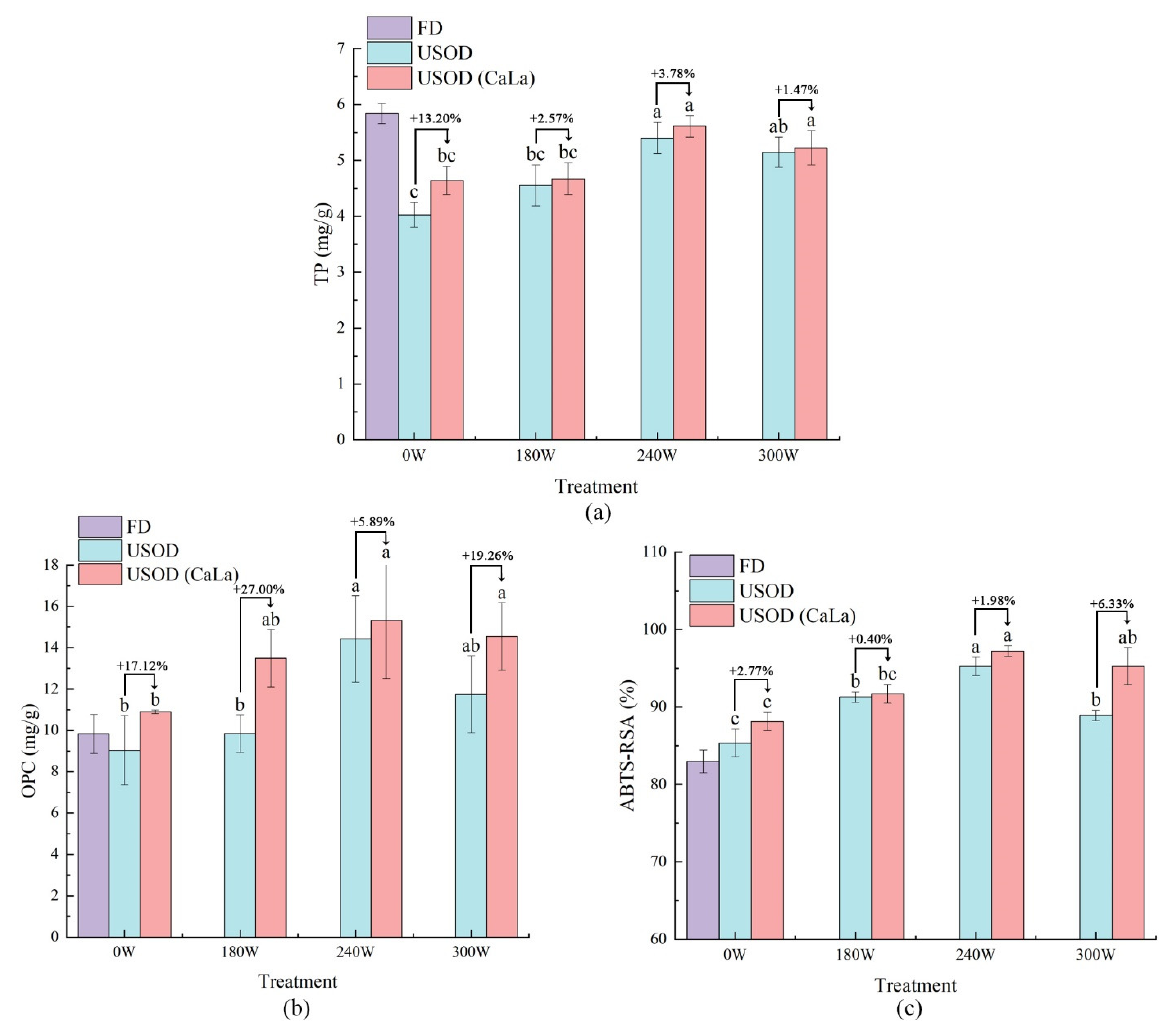
Figure 5. TP ( a ), OPC ( b ) and ABTS-RSA ( c ) of freeze-dried yellow peach slices with different treatments. The means between different ultrasonic power levels on the same conditions are indicated by different lowercase letters.